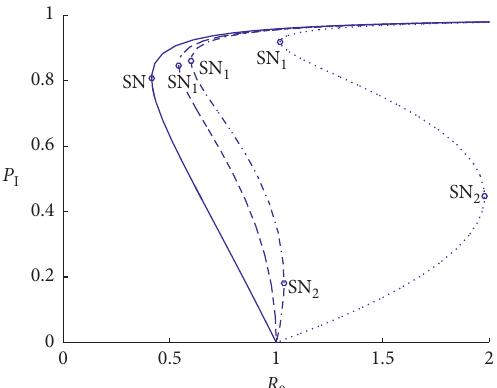
, and SN represent saddle-node points. The parameter values are c � 0 . 1, n � 6, 1 2